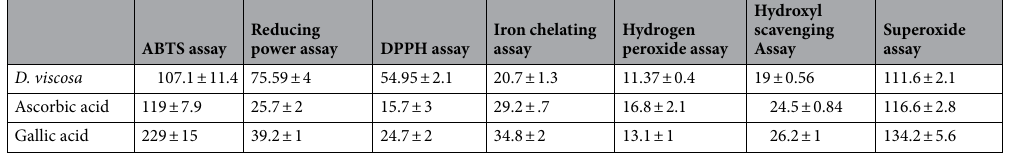
Table 6. IC 50 of different antioxidant assays. The values were measured in µg/g.